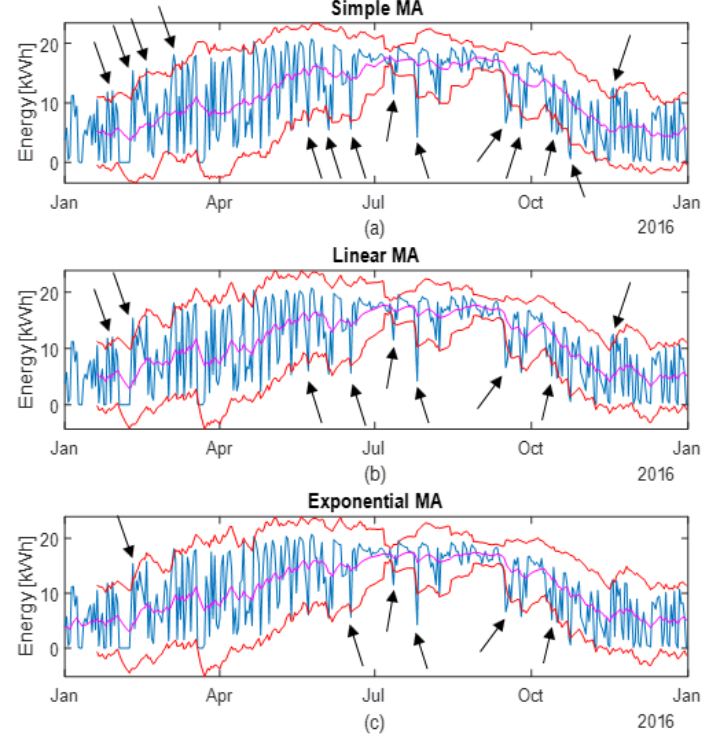
Figure 11. Comparison among the BB 20 based on SMA ( a ), LMA ( b ), and EMA ( c ). Width is 3 σ